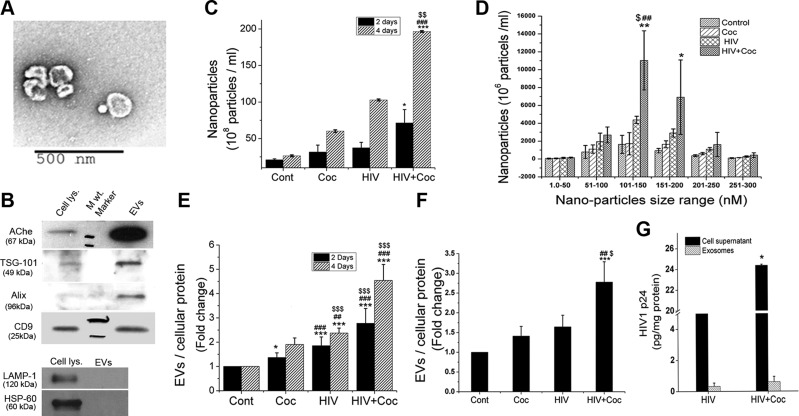
Increased release of EVs on cocaine treatment of HIV-infected MDMs. The human monomac-1 cell line and primary monocytes isolated from human peripheral blood mononuclear cells were differentiated into MDMs followed by HIV-1 bronchoalveolar lavage (5 ng/ml) infection, 1 µM cocaine (Coc) treatment, or both. EVs were isolated from supernatants collected at d 2 and 4 after infection. Isolated exosomes were analyzed for their purity, shape, and size distribution. A) Representative TEM micrograph showing EVs. Original magnification, ×10,000. B) Western blot showing comparison of exosomal protein expression in cells and isolated EVs. C, D) Quantification of EVs from monomac-1–derived macrophages. E, F) Changes in EV:cellular protein ratio after H+C treatment of macrophages derived from monomac-1 cells (E) and human primary monocytes (F). G) HIV-1 p24 levels in cellular supernatants and EV extracts, as measured by ELISA. Data are means ± sd from ≥3 independent experiments. *P < 0.05, **P < 0.01, ***P < 0.001 vs. control; ##P < 0.01, ###P < 0.001 vs. cocaine; $P < 0.05, $$P < 0.01, $$$P < 0.001 vs. HIV.